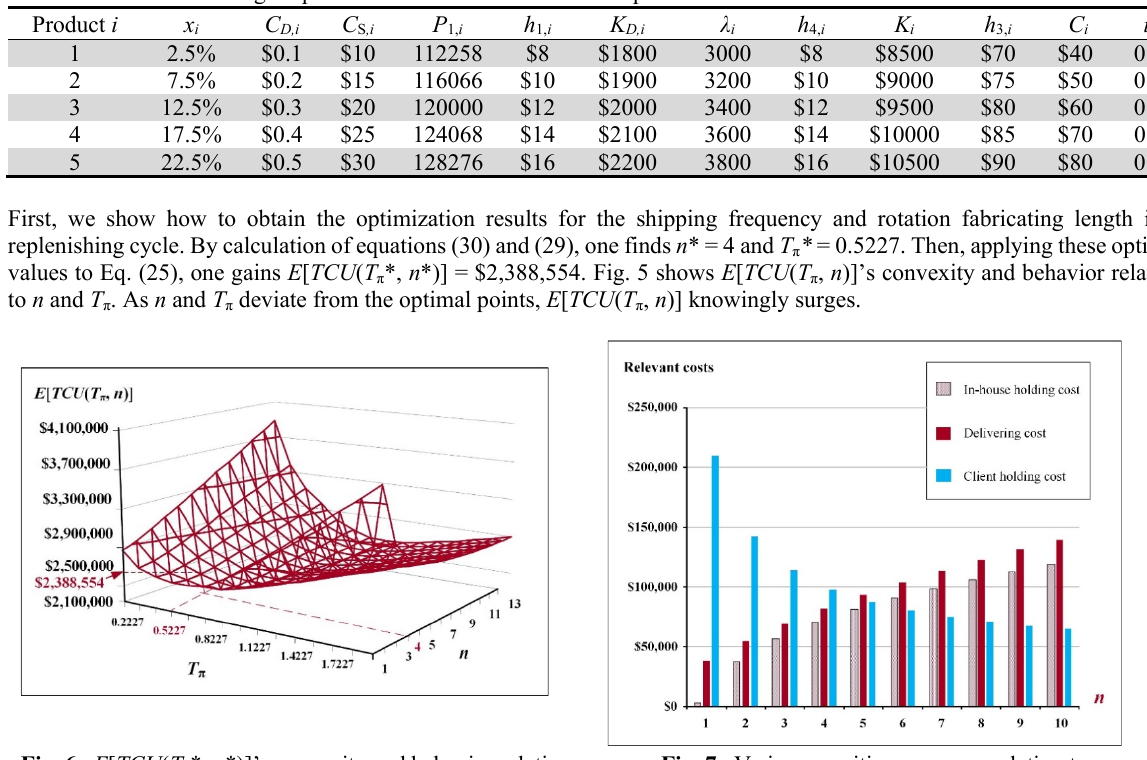
Fig. 6. E [ TCU ( T π *, n *)]’s convexity and behavior relating to n and T π